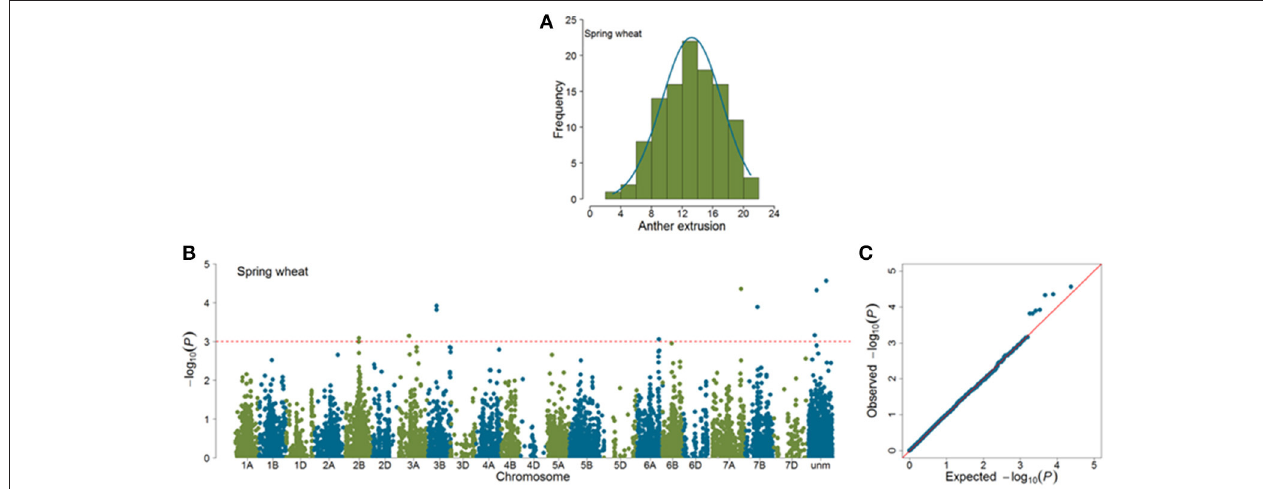
FIGURE 4 | Summary of genome-wide association studies results of anther extrusion (AE) in spring wheat panel (SP). (A) Distribution of Best Linear Unbiased Estimates of AE (B) Manhattan plots based on mixed linear model using kinship matrix ( K ) to correct for population stratification. Horizontal dashed line corresponds to the threshold ( | log 10 ( P ) | > 3.0) for MTA estimation. (C) Quantile-quantile plots depicting expected vs. observed | log 10 ( P ) | values.